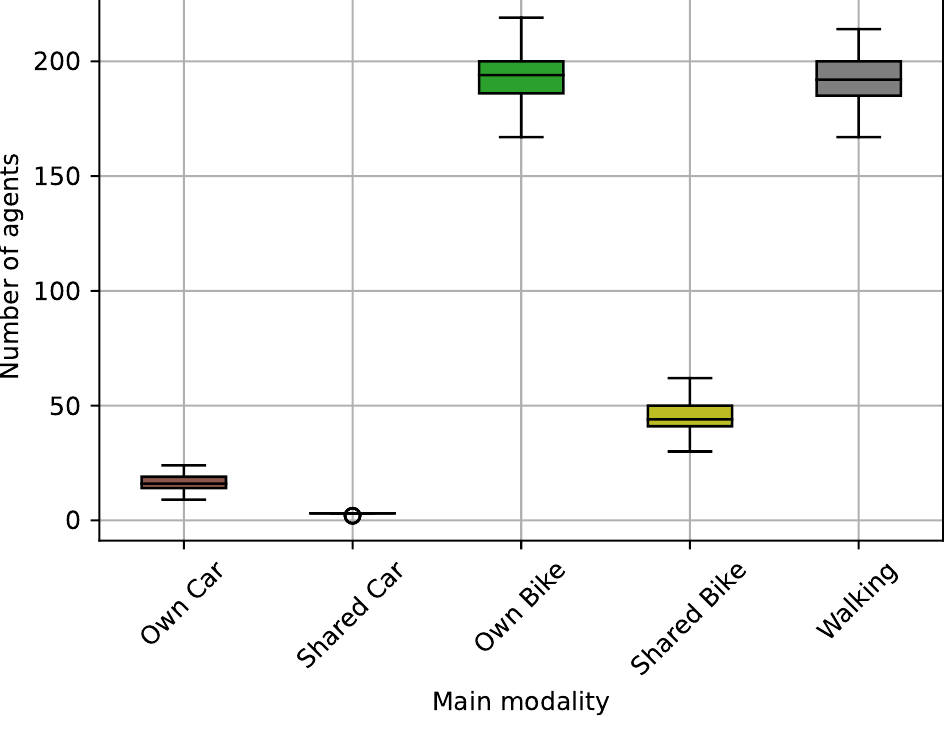
Figure 9. Box plot showing the average distribution of agents’ main modality and deviation across simulation